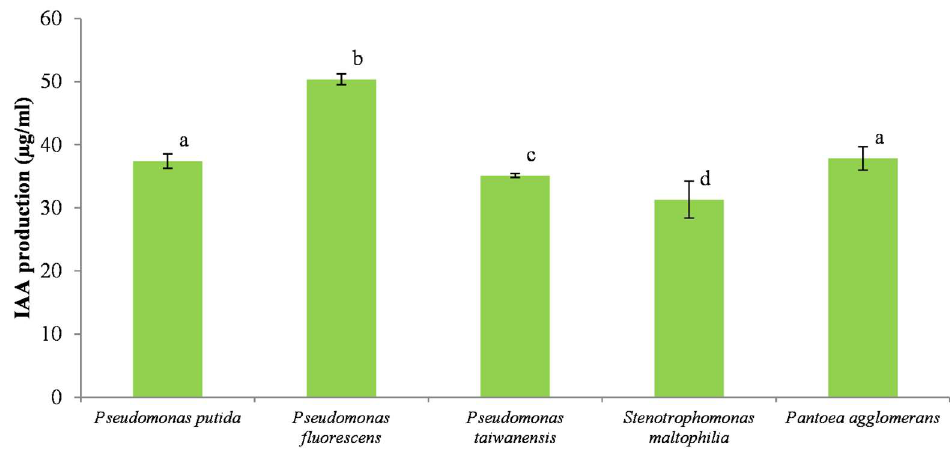
Figure 6. IAA production ( µ g/mL) by bacterial isolates. Vertical bars represent confidence intervals at a confidence level of 95% (n = 3). Same letters indicate that differences among the means is not statistically significant (Tukey’s HSD post hoc test).